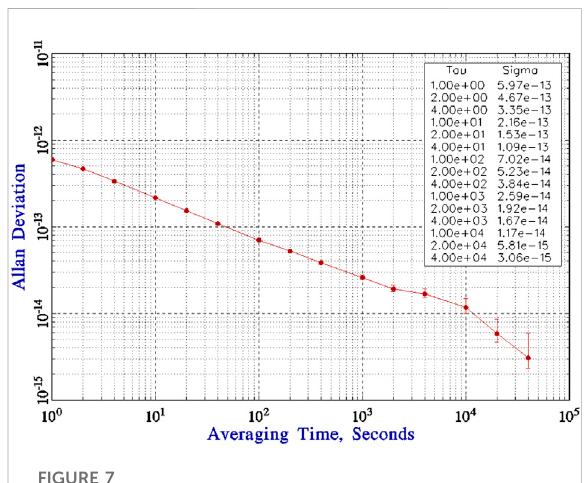
FIGURE 7 Typical Allan deviation, with no drift removed, of the clock compared against an